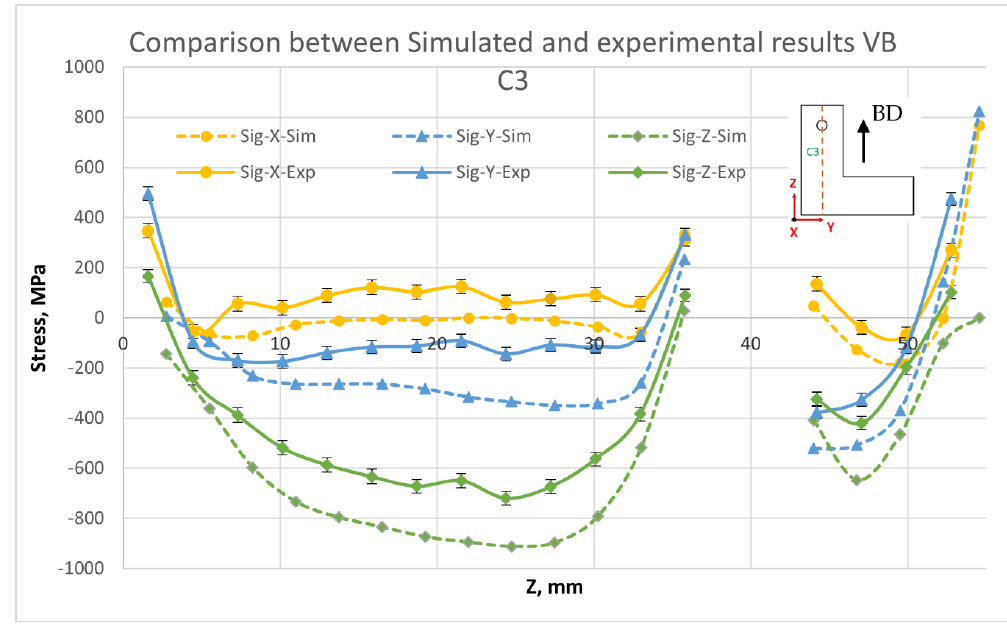
Figure 16. Comparison between experiment and simulation results for VB sample cross-section C3.